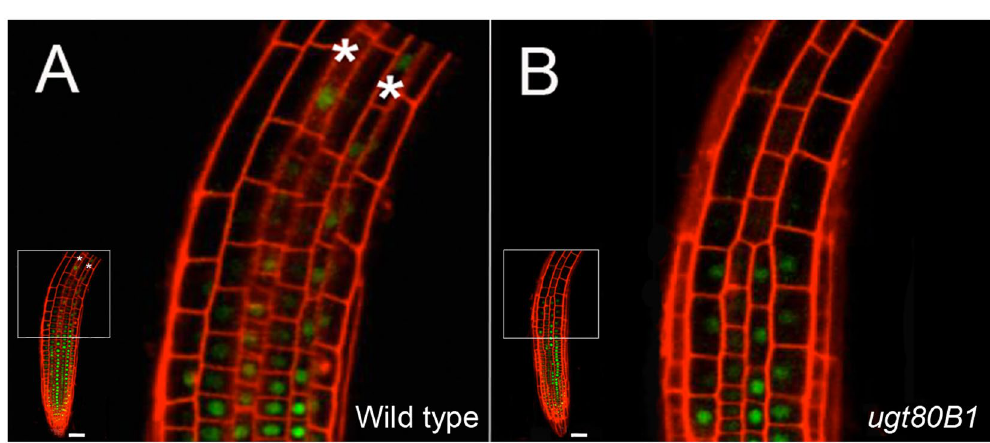
Figure 5. Abnormal expression pattern of proWER:WER:GFP in ugt80B1 mutants. Confocal microscopy imaging of WER:GFP in longitudinal sections of the epidermis from wild-type and ugt80B1 roots, counter- stained with propidium iodide to visualize cell boundaries (red) (scale bar = 50 μ m). White asterisks ( A ) indicate the accumulation of WER:GFP (green) in older/differentiating N cells in wild type. This fluorescence is absent from the corresponding cells in ugt80B1 mutants ( B